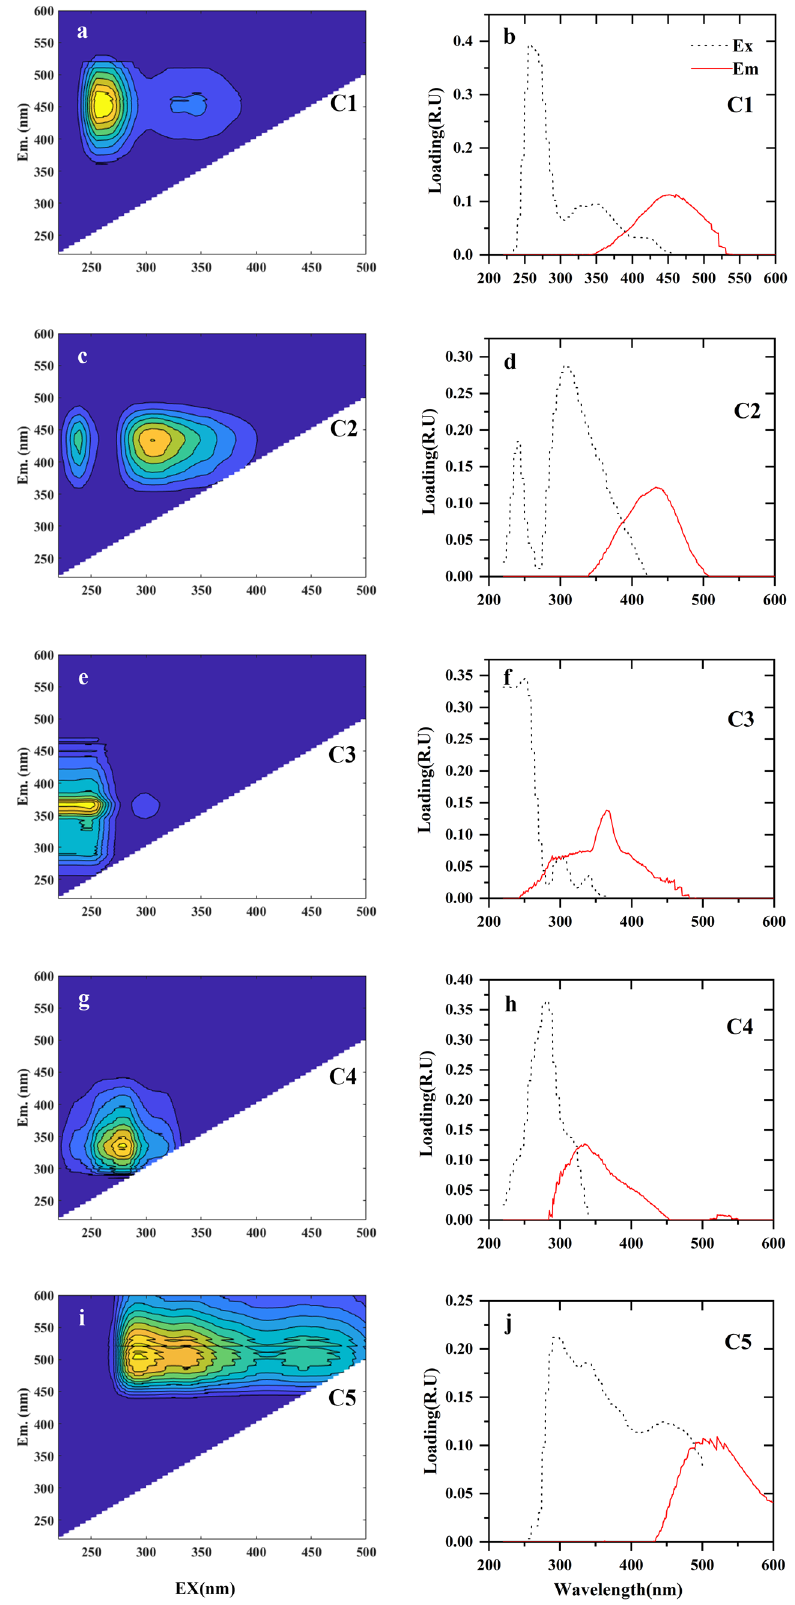
Figure A2. Contour plots of the five fluorescent components of DOM in soil samples derived using EEMs-PARAFAC, where C1 ( a , b ), C2 ( c , d ), C3 ( e , f ), C4 ( g , h ), C5 ( i , j ).